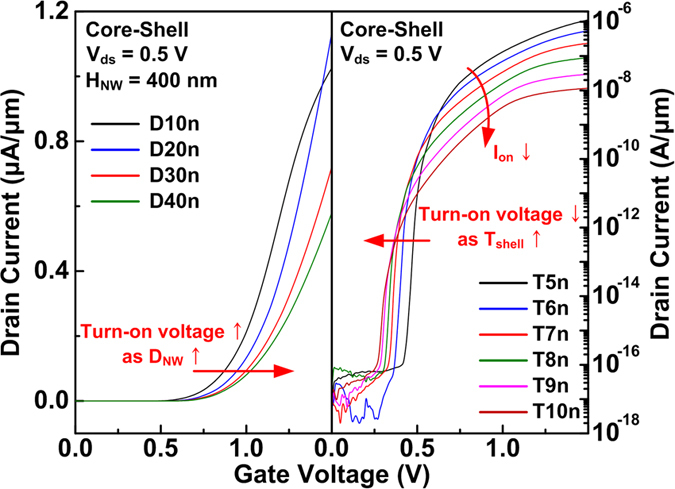
Transfer characteristics of the CS TFETs with different values of DNW and shell thickness (Tshell).